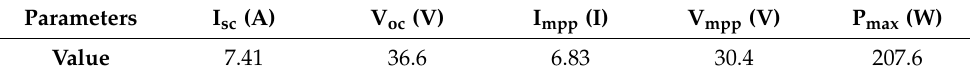
Table 2. Electrical parameters of the PV module used in temperature experiment. Table 1. Electrical parameters of PV module used in simulation experiment.